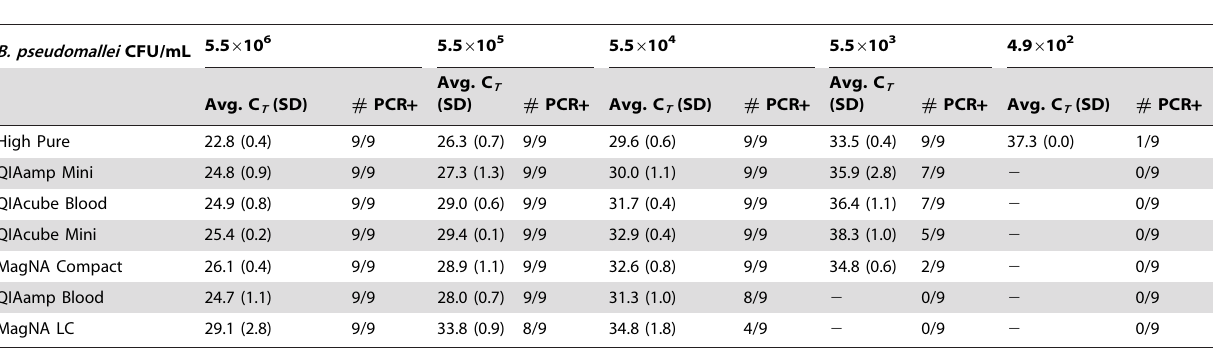
Table 2. Comparison of seven DNA extraction kits based on the average crossing threshold (C T ) values, standard deviation and number of PCR positives using the TTS1 real-time PCR